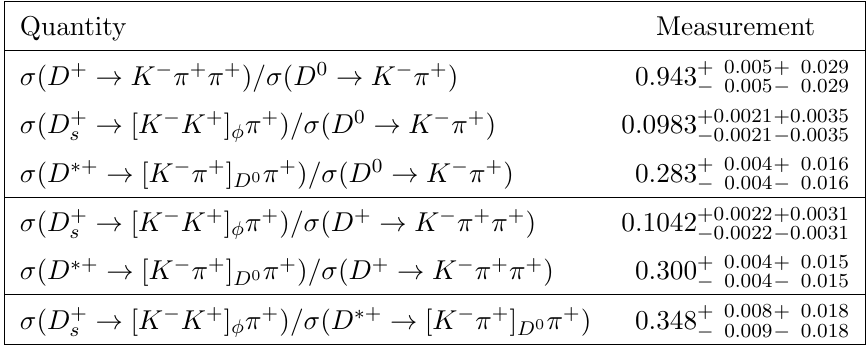
f ) is shorthand for (cid:27) ( D ) ( D f ! (cid:2) B !